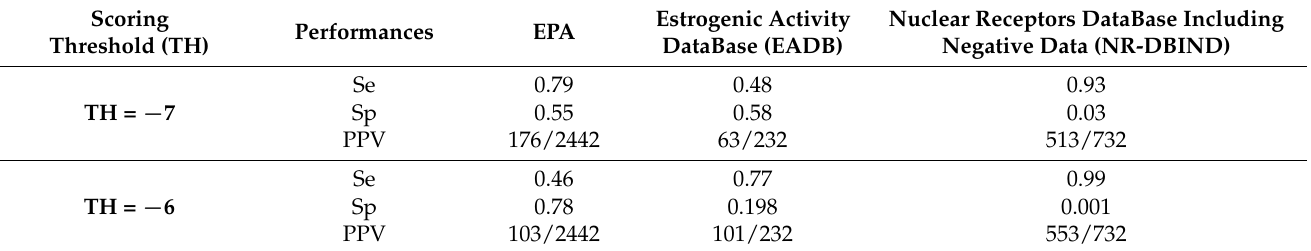
Table 3. Sensitivities (Se), specificities (Sp), and positive predictive value (PPV) calculated for the single docking approach with smina_dkoes scoring function screening for both TH = − 6 and TH = − 7 scoring thresholds.